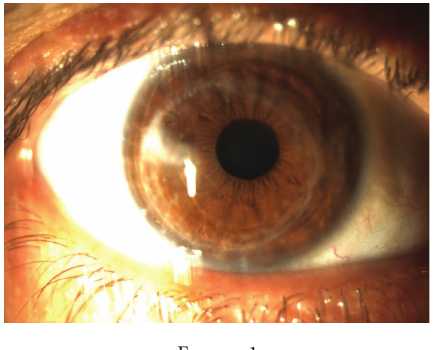
and digital image processing [10, 13, 14]. Afshari et al. reported that good results may be achieved in most of the cases by using a 8 mm graft with a 0.5 mm decentralization [13]. We used the same method for our patient. Digital corneal image and computer software were used to plan the graft size and centralization [14]. By adjusting graft size, location, and amount of rotation, centralization of clear cornea at pupillary axis and scar location for best cosmetic result can be